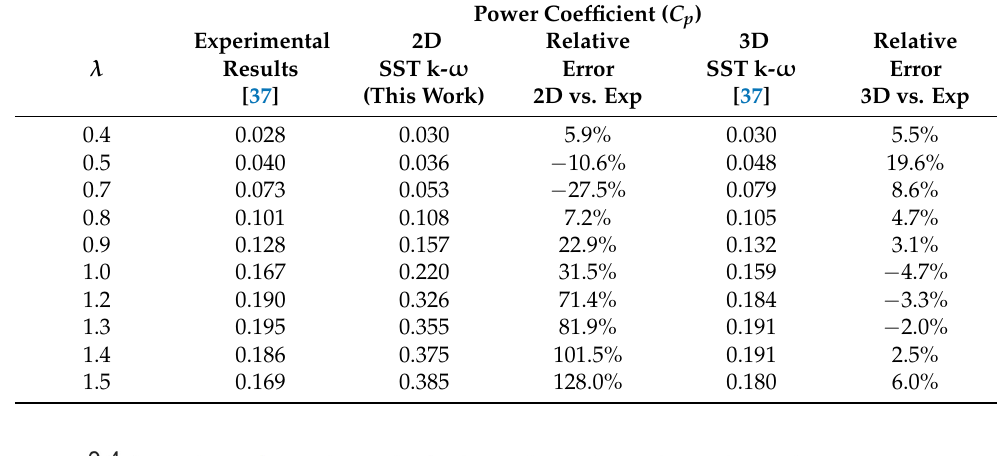
Table 6. Power Coefficient Comparison of 2D SST k- ω Simulation with Experimental Data and 3D SST k- ω Simulation Results.